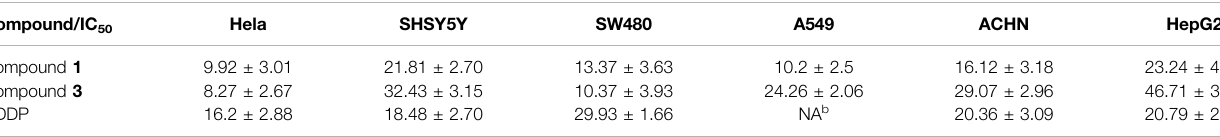
TABLE 3 | Cytotoxic activity of compounds 1 and 3 (IC 50 , μ M) a